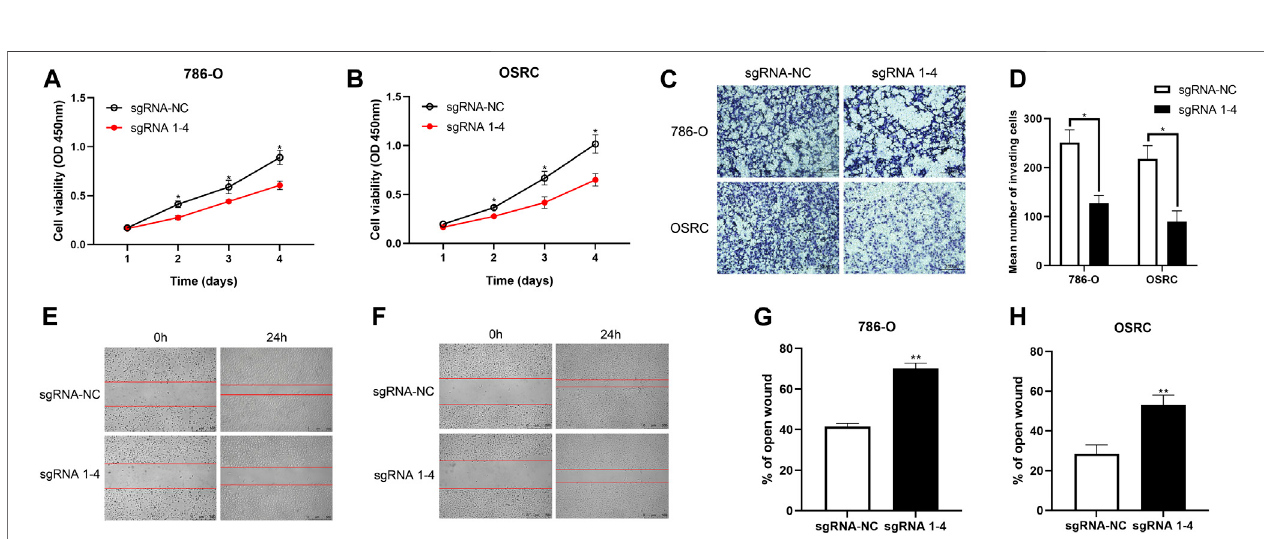
FIGURE4| ProliferationandmigrationassayscarriedoutwithRCCcellstransienttransfectedwithTRIM58-TET1vector. (A , B) CCK-8assayforcellproliferationof TRIM58-TET1 transient transfected 786-O and OS-RC-2 cells; (C , D) Transwell assays for the migration ability of 786-O and OS-RC-2 cells; (E – H) The wound-healing assays for TRIM58 demethylation in both RCC